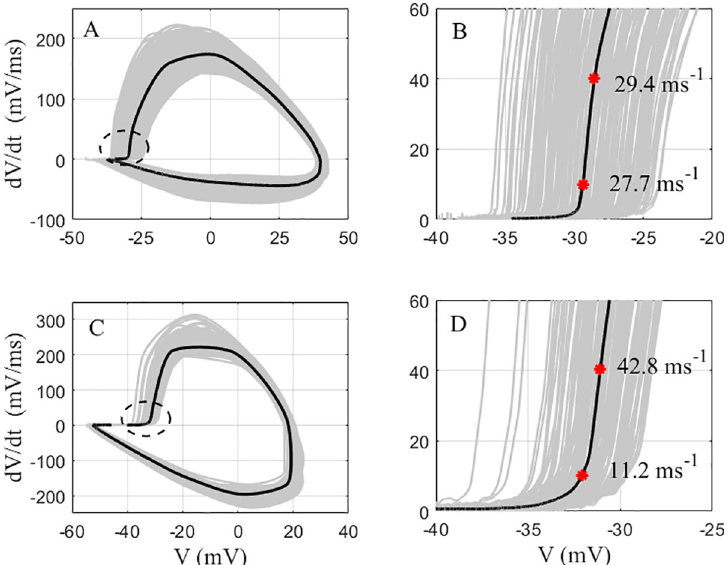
Fig 4. Comparison of the impact of the phase slope criterion level between a hippocampal pyrmidal neuron and a hippocampal PVBC. A: A cumulative phase plot of the APs from a hippocampal pyrmidal neuron (gray), and their average (black). B: The portion of the phase plot of A near onset. C: A cumulative phase plot of the APs from a hippocampal PVBC (gray), and their average (black). D: The portion of the phase plot of C near onset. The red astericks in C and D represent the points at which the average _ V _ reached 10 mV/ms and 40 mV/ms, and the values m next to the astericks are the phase slopes at those points.